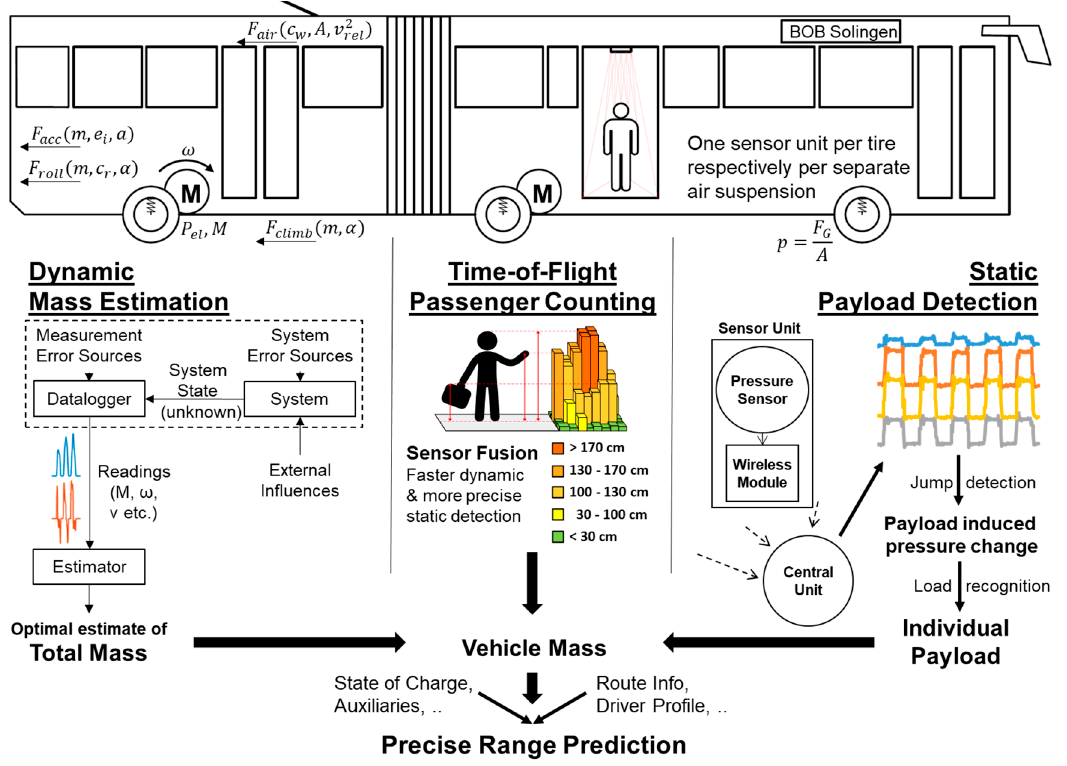
Figure 4. Overview of the combined vehicle mass detection system.